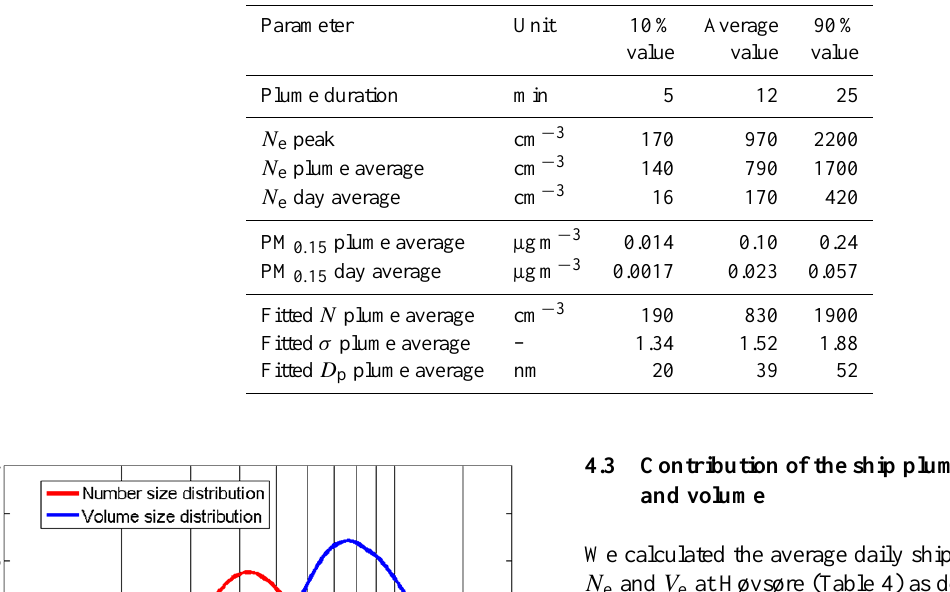
Table 2. Characteristic values of the plumes. Calculation of N e peak, plume average and day average. The average fitted number concentration N , geometric standard deviation σ and mode peak diameter D p (with 10 and 90% values) of N e .